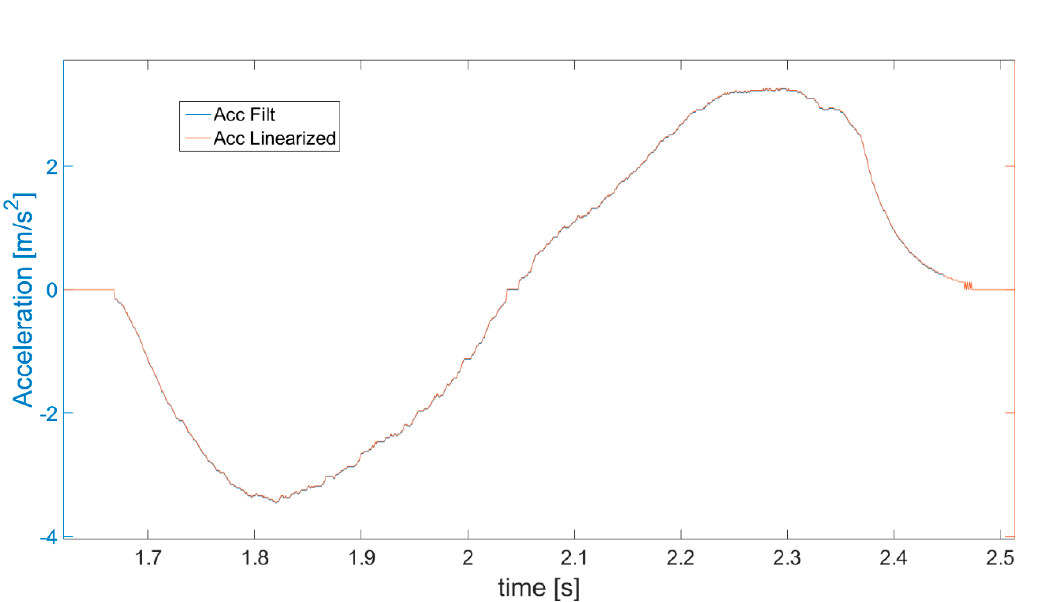
Figure 9. Acceleration values calculated after performing the symmetrization (Acc linearized).